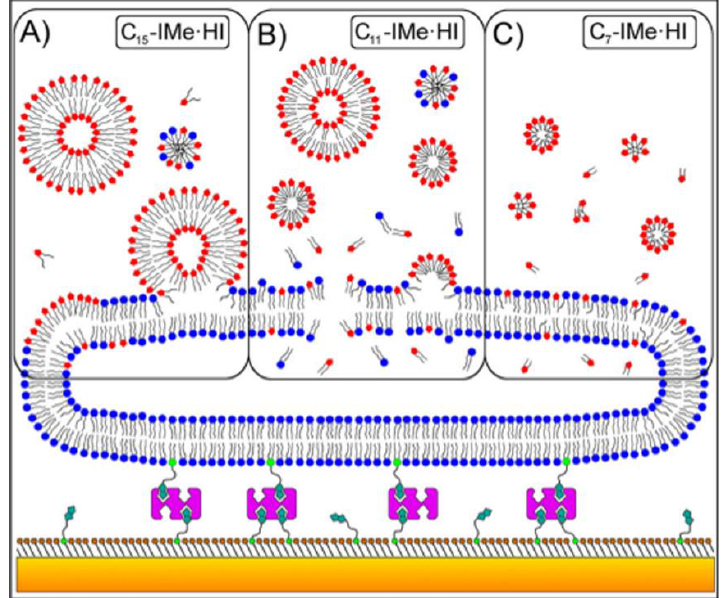
Figure 3. A model of the interaction between ILs (imidazolium-based) and bio-membranes where a gold-coated sensor surface (orange) has a chemisorbed self-assembled monolayer (brown) tethered by biotin linkers (green) to streptavidin which also tethers liposomes (blue). Panel ( A ) depicts a vesicle, which can then associate and intercalate into the bilayer membrane. Panel ( B ) focuses largely on mechanisms causing lyses to the membrane by forming vesicles or micelles in an aqueous medium, thereafter disrupting the membrane structure. Panel ( C ) focuses on mechanisms that allow pass-through within the membrane by disassociating into single molecules. Adapted with permission from Drucker 2017 [48]; © 2017, American Chemical Society.